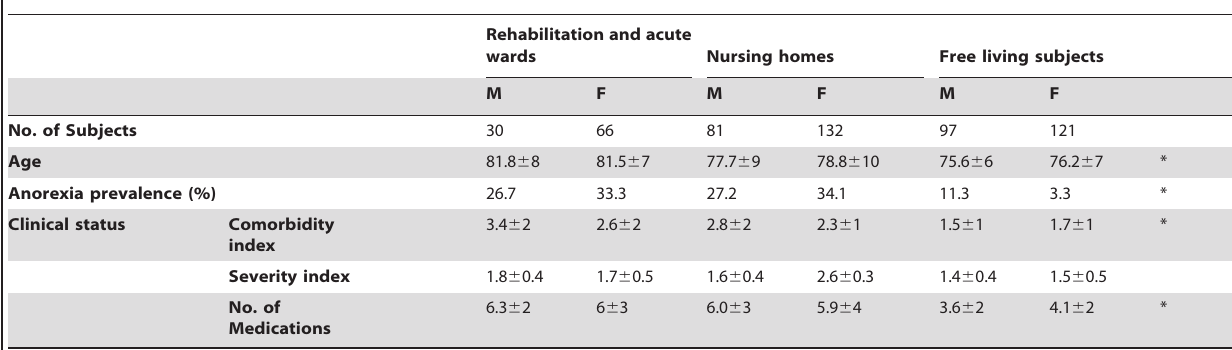
Table 1. Characteristics of the Study Participants 1